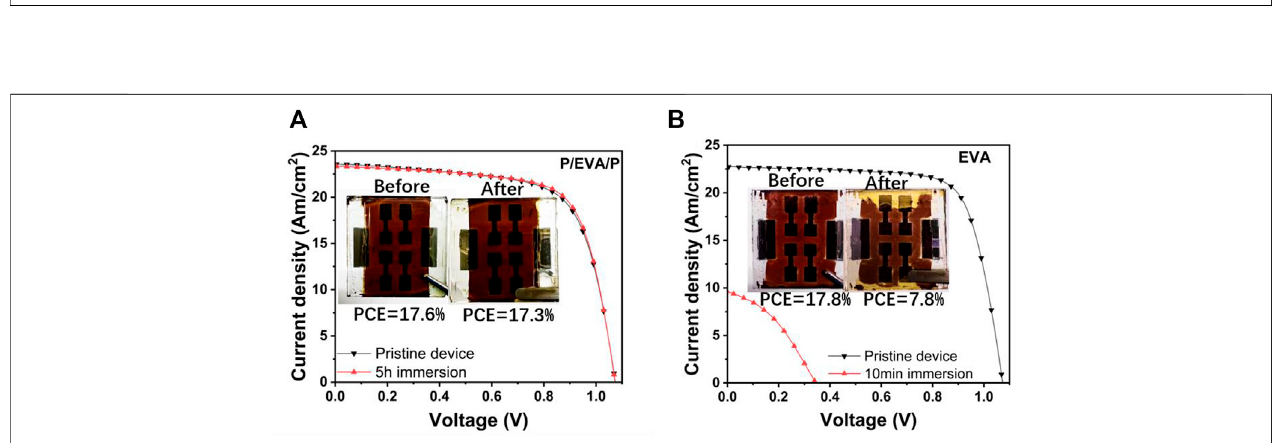
FIGURE 7 | Long-term stability of PSCs encapsulated with different melting point paraf fi n in 85% humidity and 60 ° C. Normalized PCE (A) , V (D) evolution of encapsulated PSCs with time.